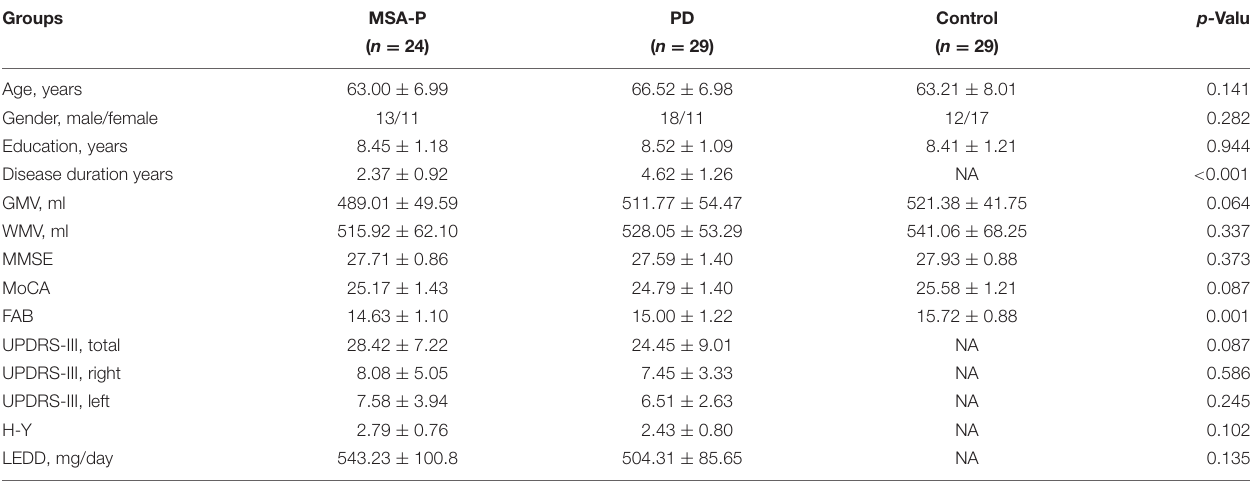
TABLE 2 | Demographic and clinical characteristics of the participants.